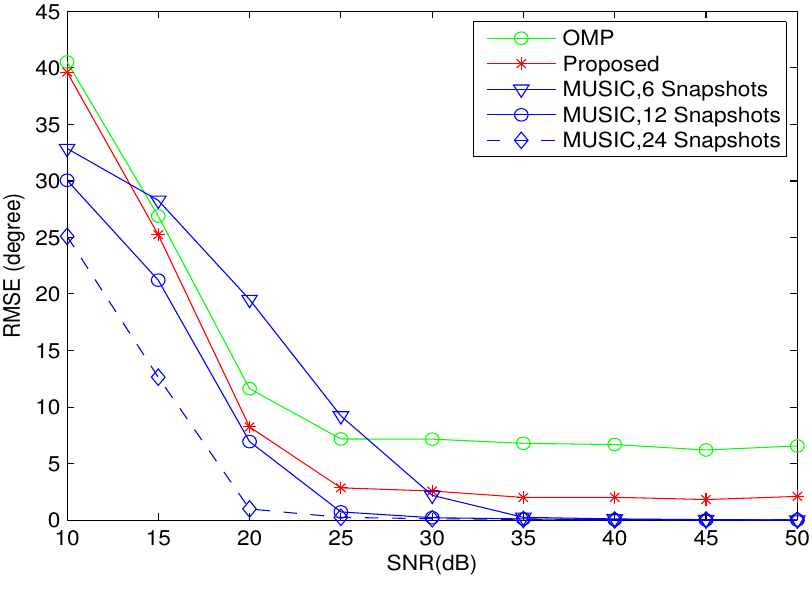
Figure 8. Root mean square error as a function of SNR . Four sources are assumed from the DOAs: {− 25 . 7 ◦ , − 5 . 7 ◦ , − 1 . 7 ◦ , 29 . 3 ◦ } . The minimal DOA difference is 4 ◦ , and the grid spacing is 1 ◦ . The number of array elements is M = 12 . The curves were obtained by averaging the results of 100 independent simulation